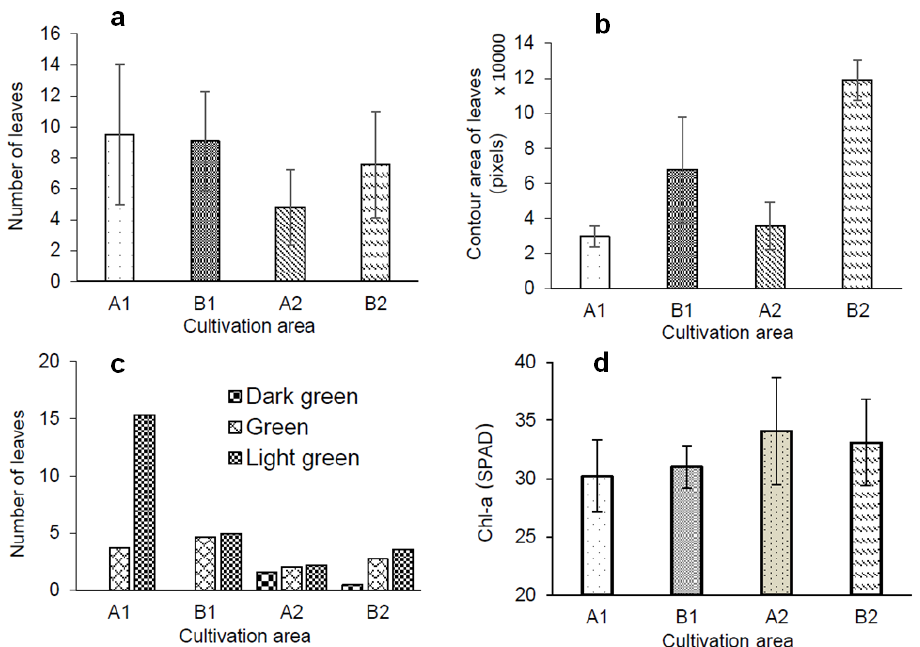
Figure 15. Comparison of the lighting treatment in the second stage: ( a ) number of leaves, ( b ) contour area of leaves, ( c ) leaf colour, and ( d ) relative chlorophyll-a. Table 4. Comparison of the results of estimating the number of diseased leaves using automatic and manual measurement.